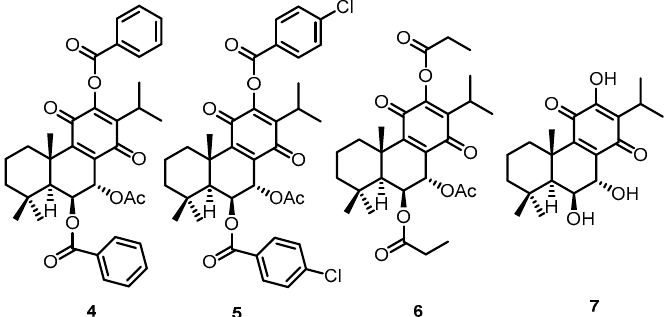
Figure 2. Chemical structures of semi-synthetic derivatives: ( 4 ) RoyBz, ( 5 ) RoyBzCl, ( 6 ) RoyPr 2 , and ( 7 ) DihydroxyRoy.